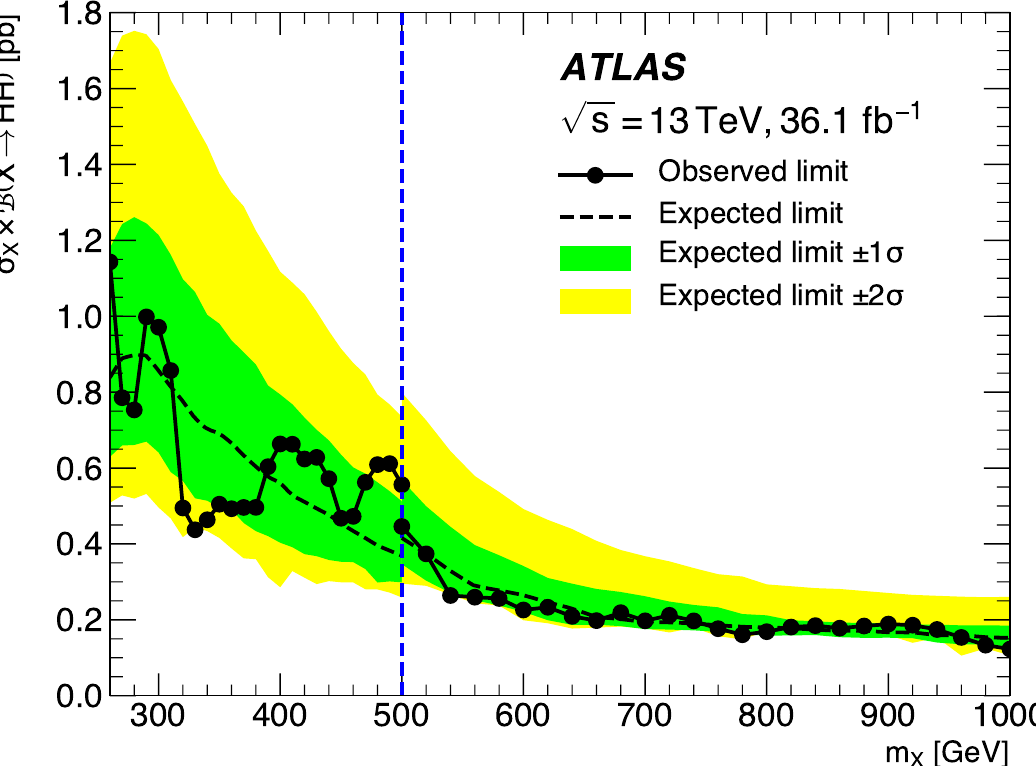
Figure 7. The expected and observed 95% CL limits on the resonant production cross-section, (cid:27) X (cid:2) B ( X ! HH ) as a function of m X . The loose selection is used for m X (cid:20) 500GeV, while the tight selection is used for m X (cid:21) 500GeV. This is delineated with the blue dashed